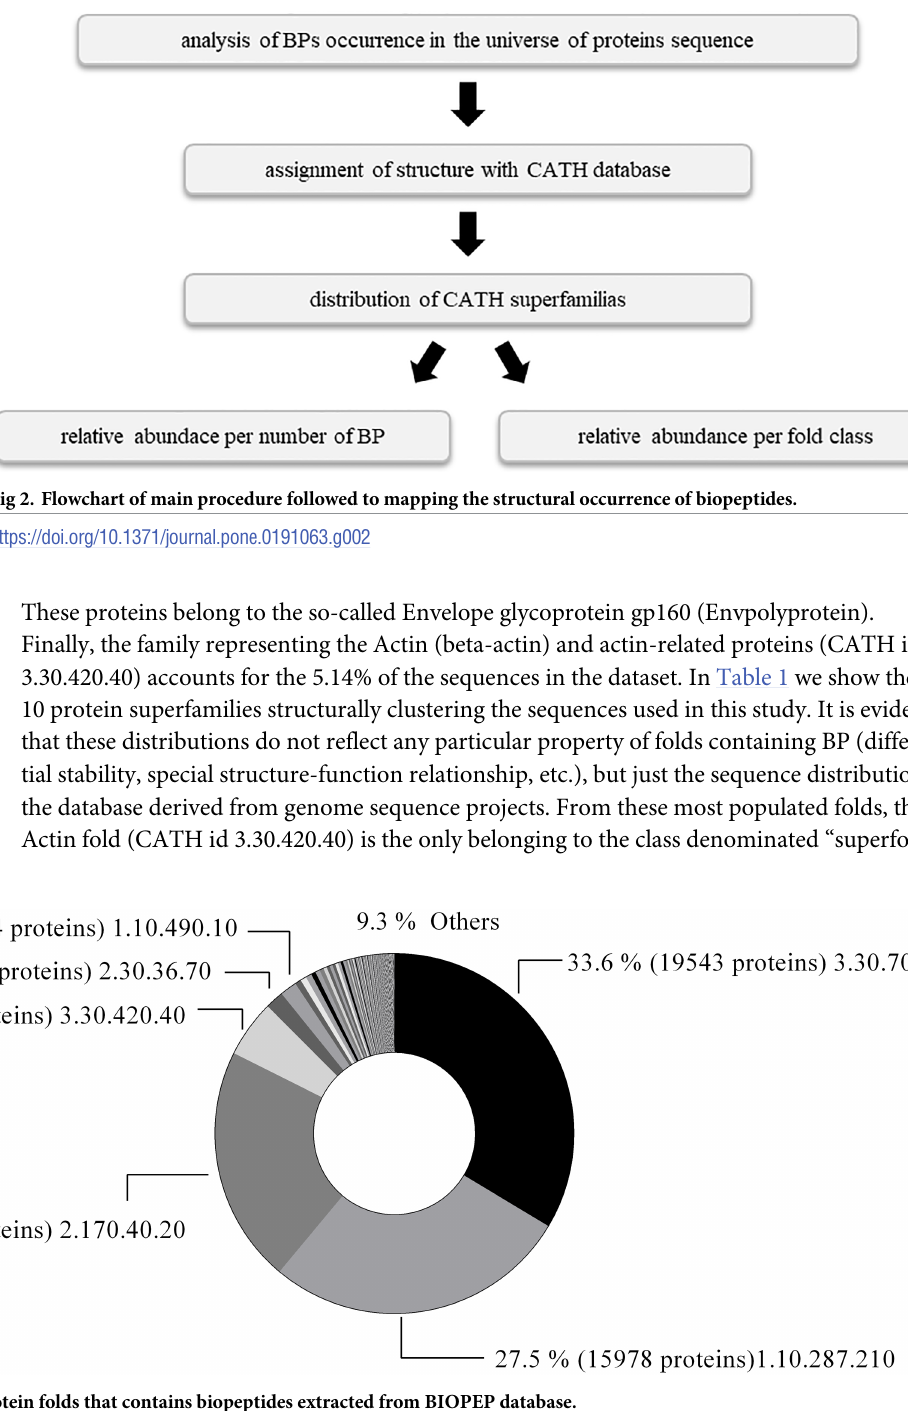
Fig 3. Distribution of protein folds that contains biopeptides extracted from BIOPEP